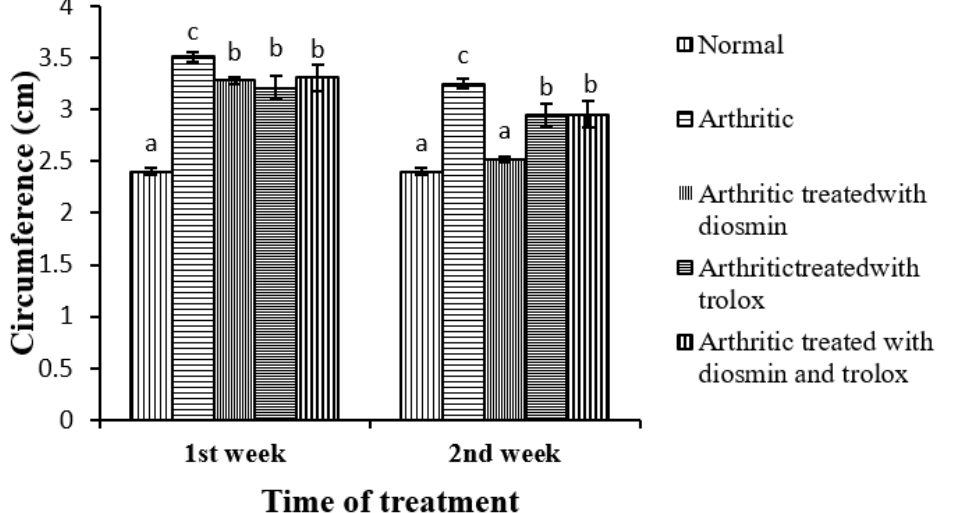
Figure 3. Effect of diosmin, trolox, and their combination on the circumference of the right hind paw in CFA-induced arthritic rats. Means with the same superscript symbol(s) are not statistically significant. a, b, and c refer to similarity or non-similarity between groups. Data are expressed as mean ± standard error and each group has a total of six individuals.